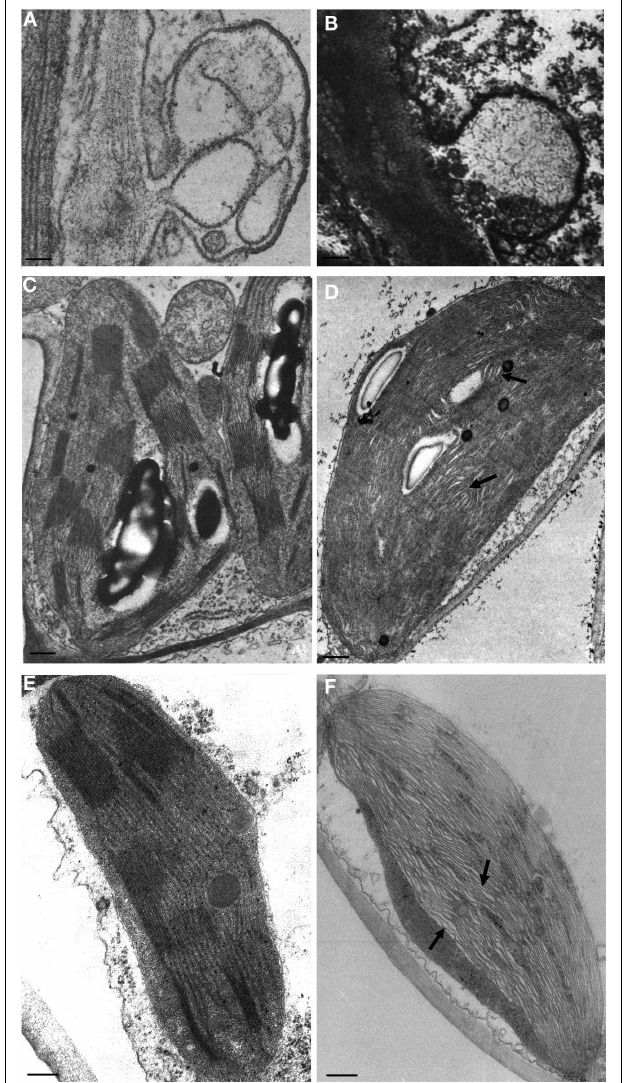
FIGURE 1 | Cytopathic effects associated to viroid infection. Plasmalemmasomes in tomato infected by PSTVd (A) , and in avocado infected by ASBVd (B) . Normal and malformed chloroplasts with irregularly stacked thylakoids and wide interspaces (denoted with arrows) in healthy and PSTVd-infected tomato [ (C,D) respectively], and in peach healthy and infected with a PLMVd latent variant [ (E,F) respectively). Bar = 50nm. (A,C,D) have been reproduced (with modifications) from Hari (1980; CopyrightThe American Phytopathological Society), and (B) from Da Graça and Martin, 1981; Copyright JohnWiley and Sons), in all cases with